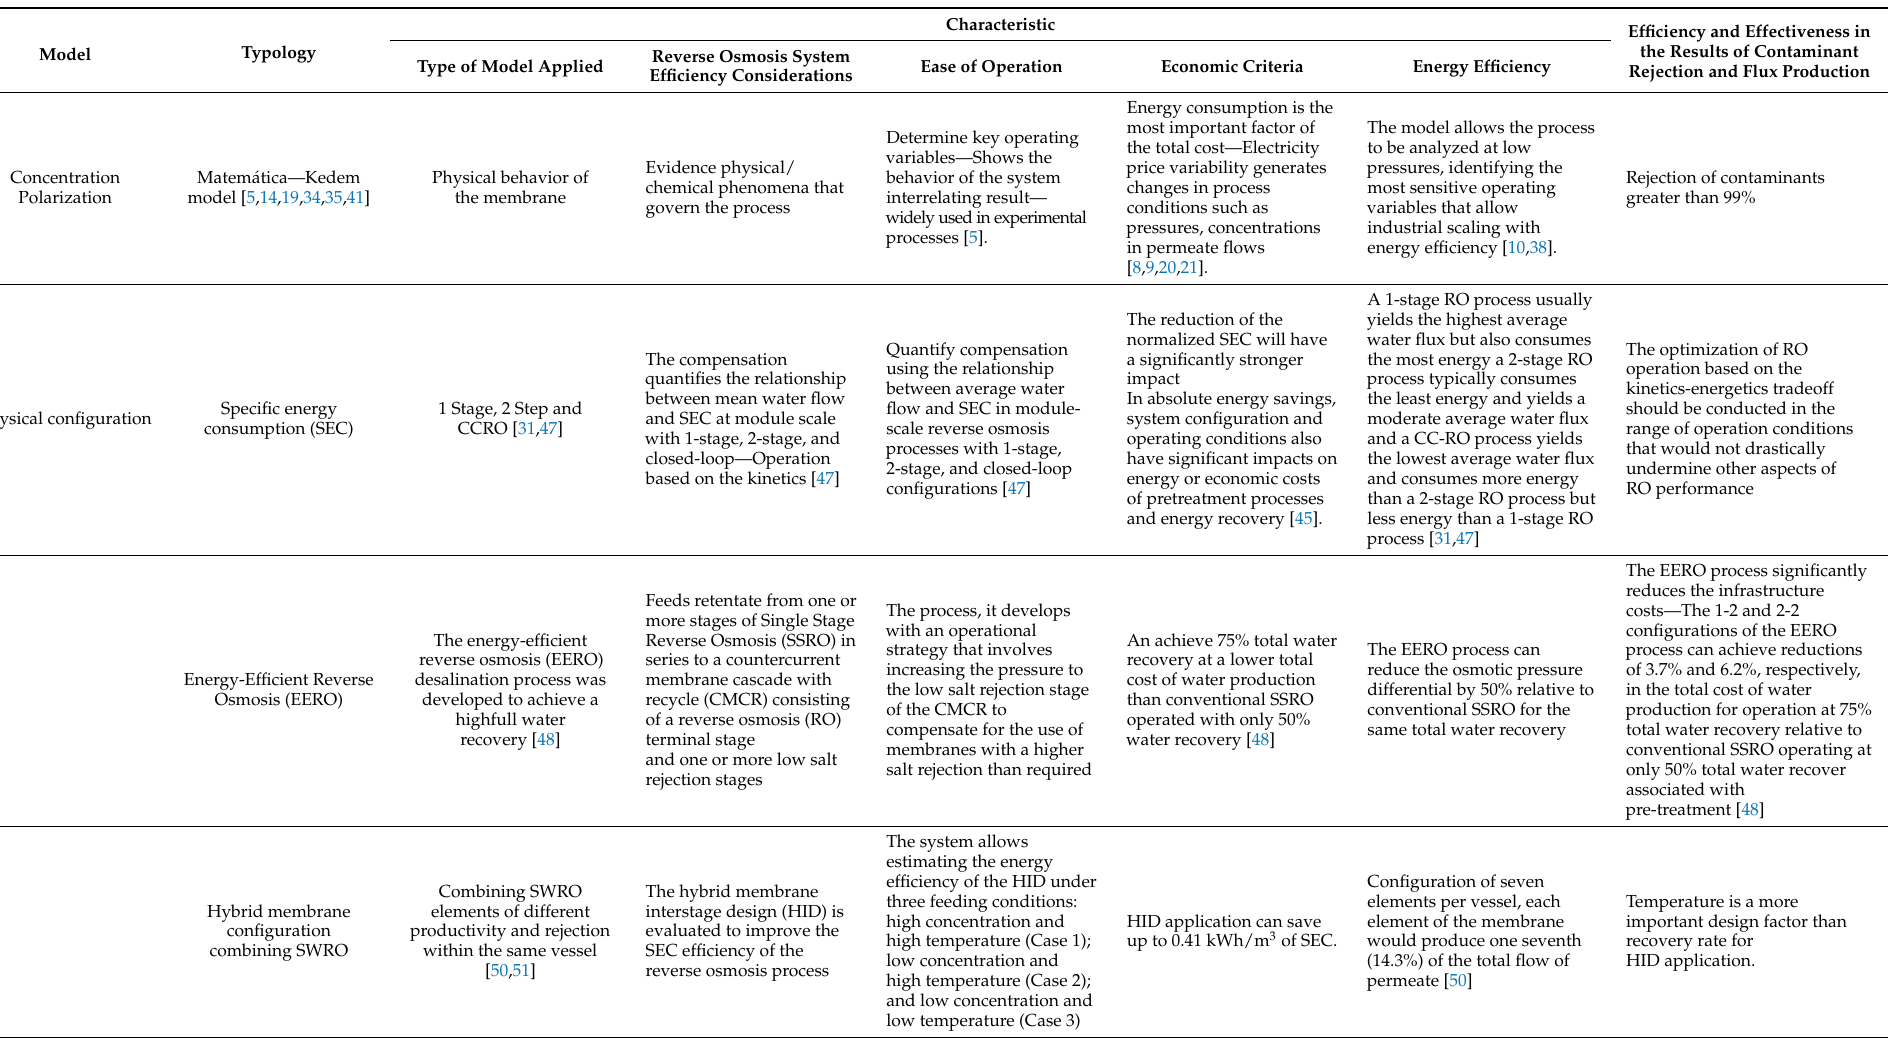
Table 1. The main characteristics and comparison of the